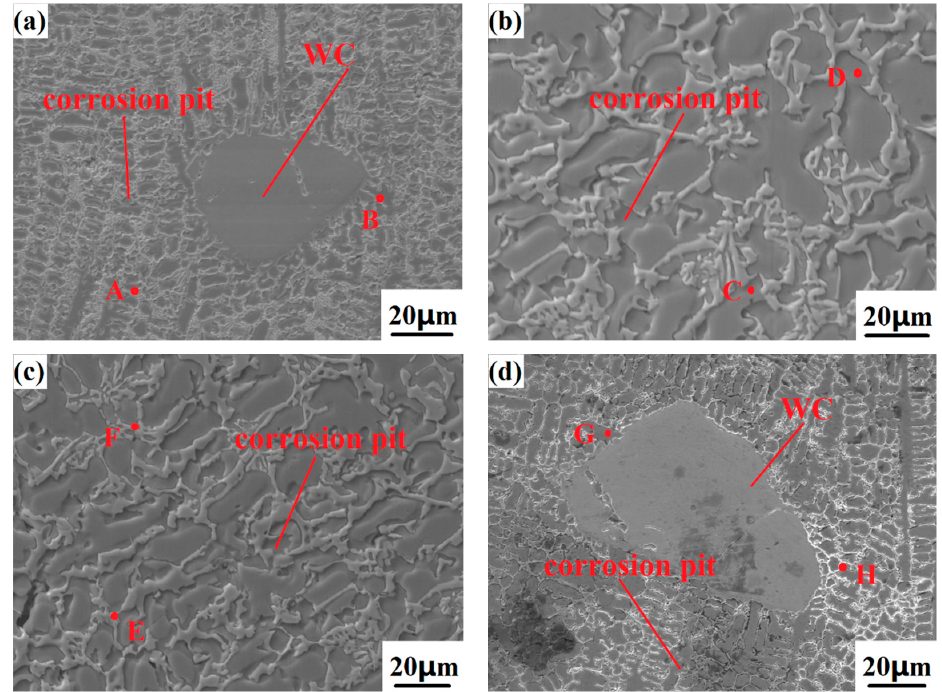
Figure 13. SEM surface corrosion morphologies of Co-Cr-WC composite alloy cladding layers with different mass fractions of WC. ( a ) Co-Cr-10%WC; ( b ) Co-Cr-20%WC; ( c ) Co-Cr-30%WC; ( d ) Co-Cr- 40% WC. Table 5. EDS point scanning analysis of Co-Cr-WC composite alloy cladding layer after corrosion.